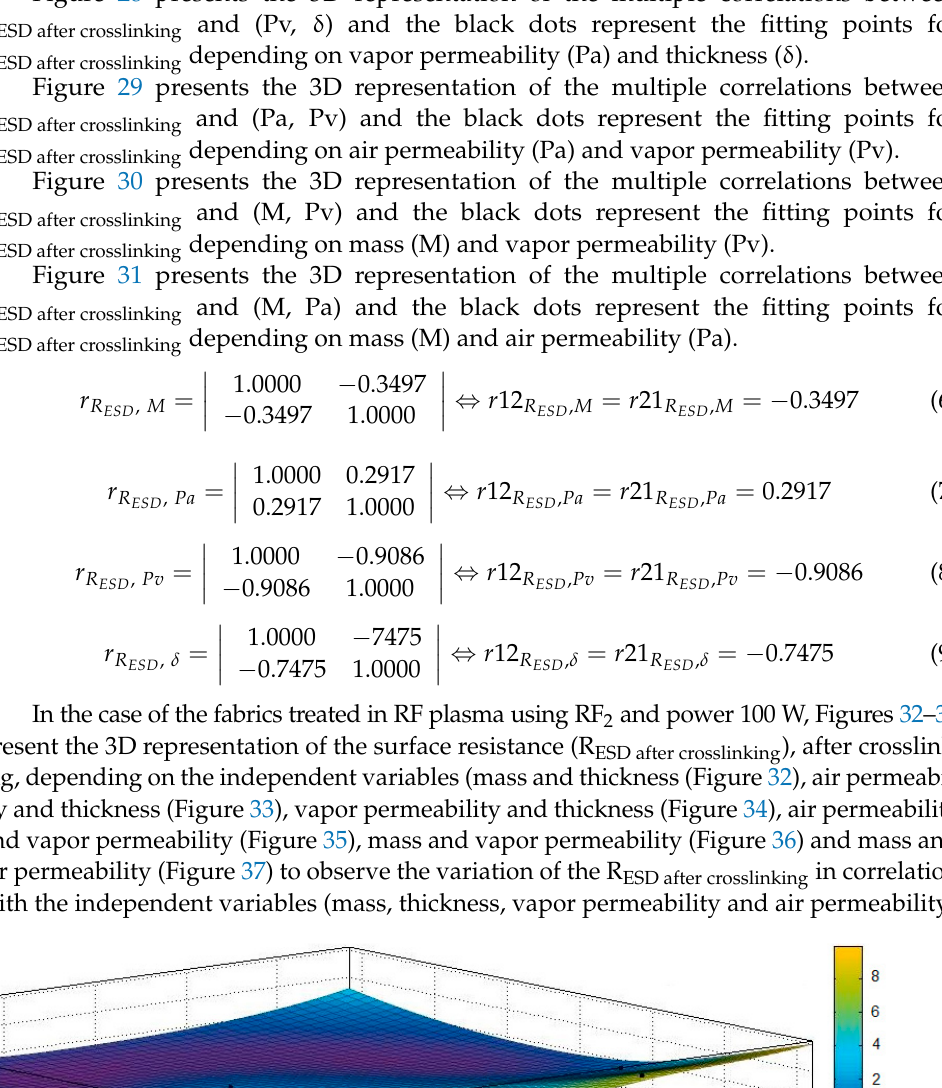
Figure 33. 3D representation R ESD after crosslinking = f(Pa, δ ) samples preliminarily treated in RF plasma O 2 using RF 2 generator and power 100 W.